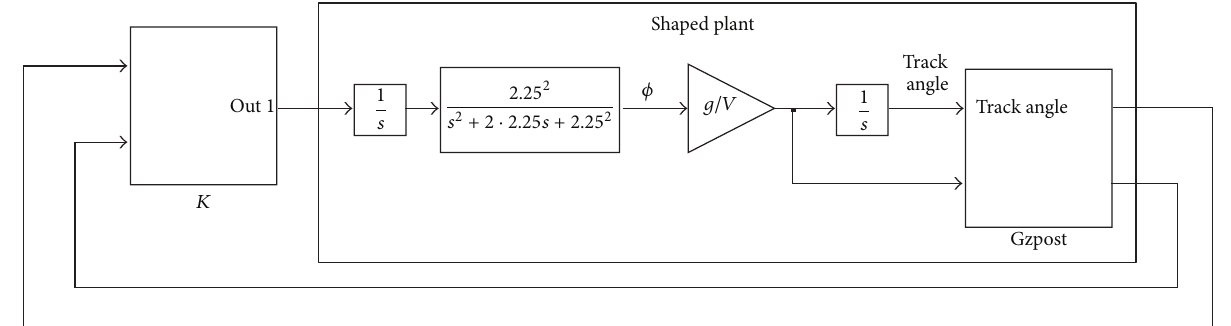
Figure 6: Outer-loop heading angle and lateral deviation controller.